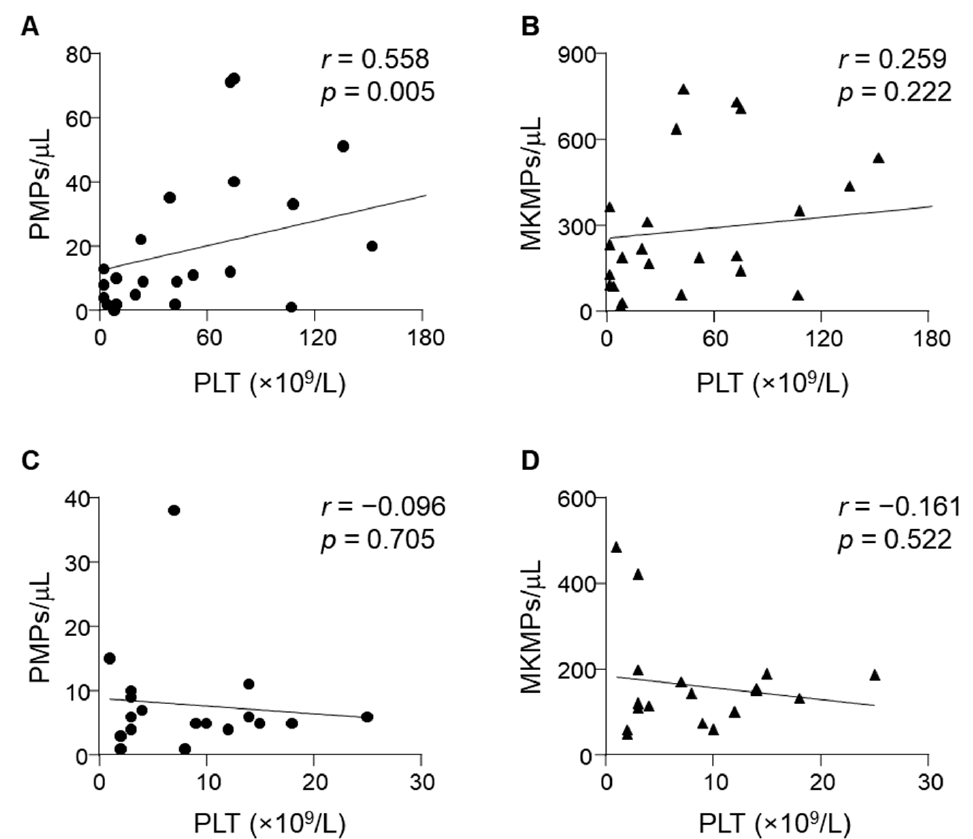
Figure 5. Correlation analysis between plasma MP levels and platelet counts. The Spearman correlation analysis was performed between plasma MP levels and platelet counts in responders (( A , B ), n = 12) and non-responders (( C , D ), n = 9) during the course of treatment. A positive correlation was found between PMPs and PLT counts in the responders (( A ), r = 0.558, p =